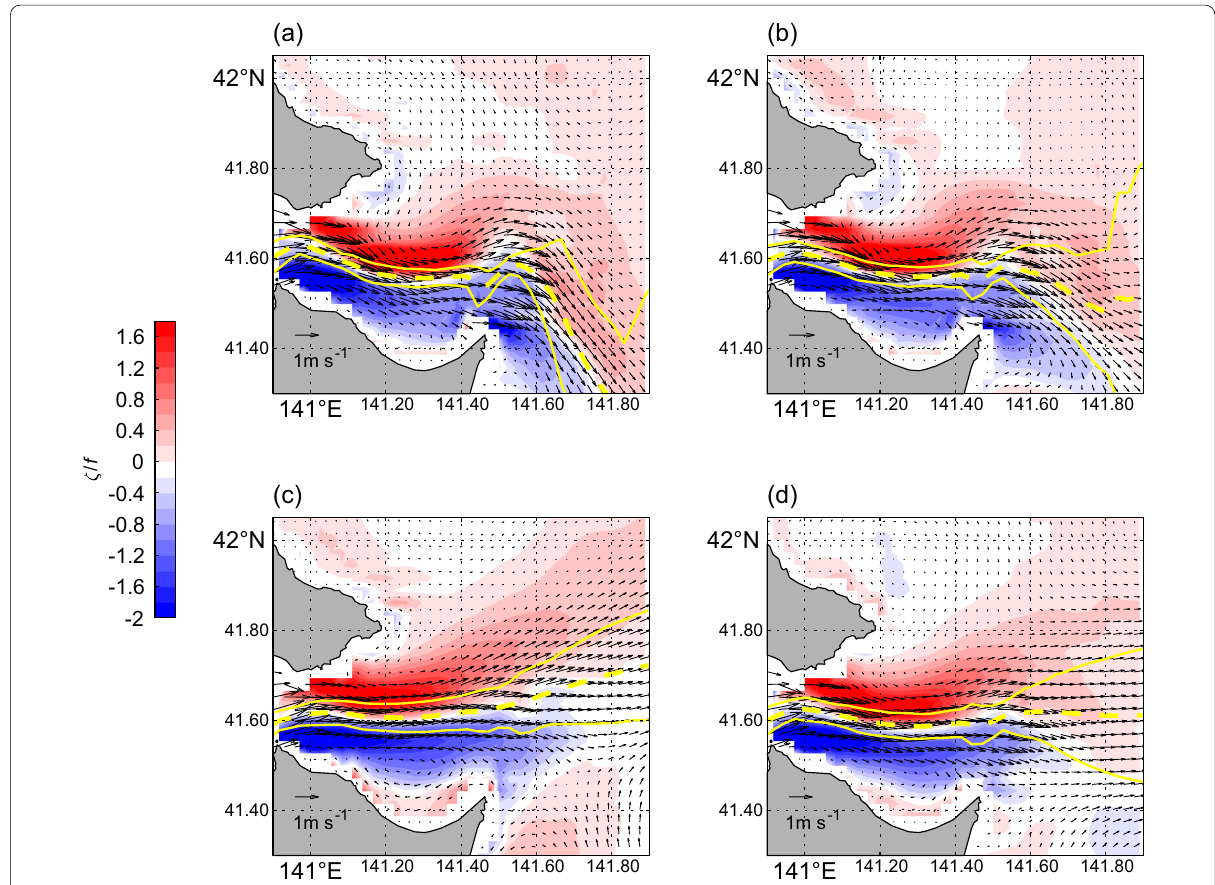
Fig. 5 Seasonal mean of the surface velocity obtained from the JCOPE-T DA data in a winter, b spring, c summer, and d autumn. The color and yellow lines are the same as those in Fig.